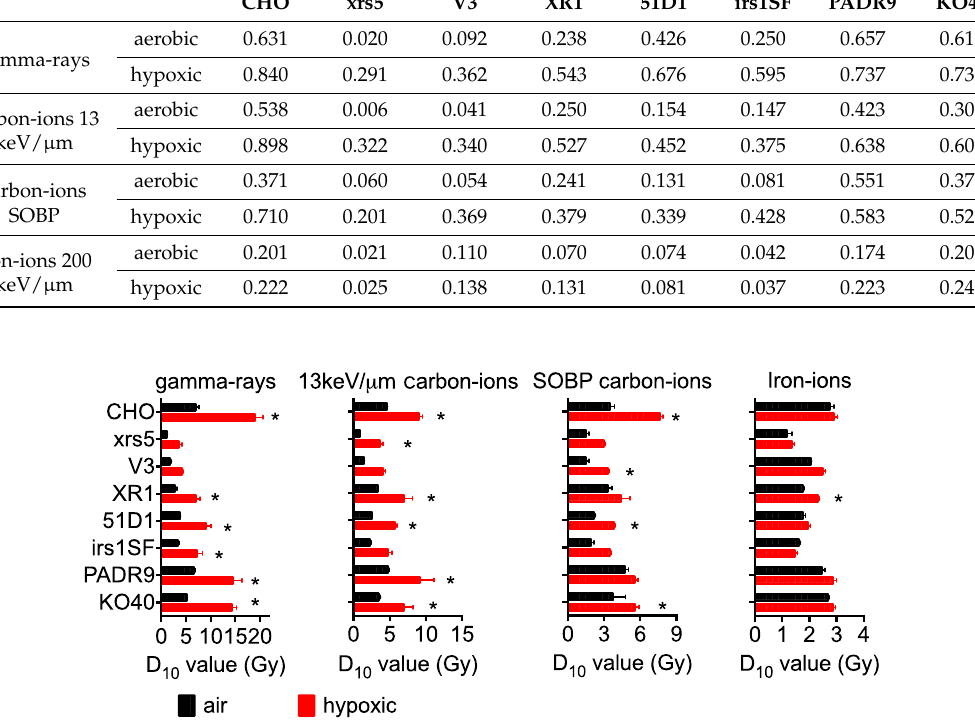
Table 1. SF2, survival fraction at 2 Gy, for different qualities of radiation.